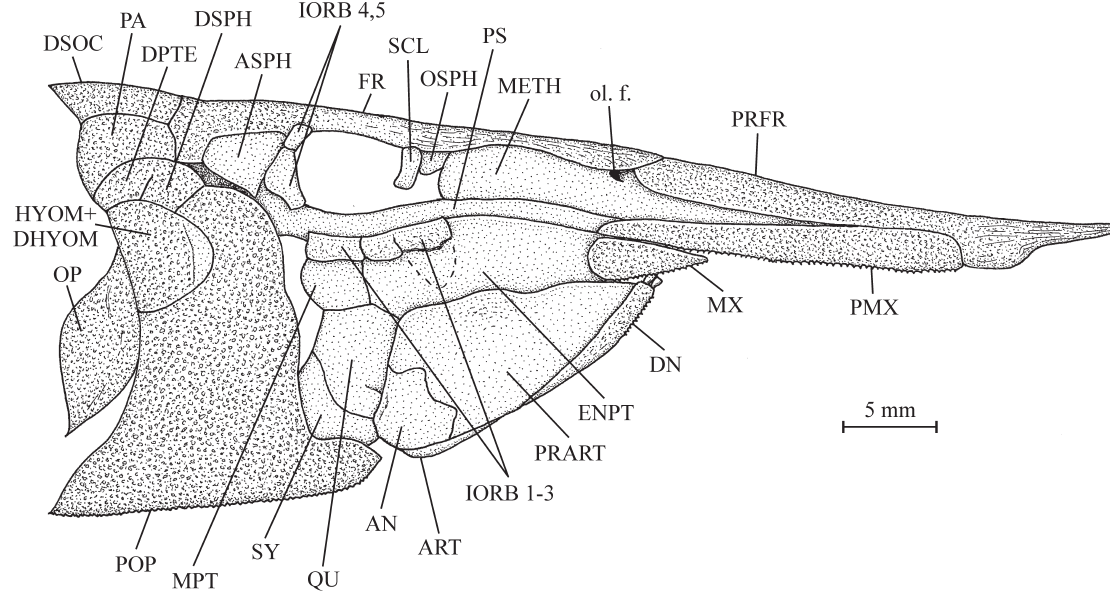
Fig. 3. Gladiopycnodus karami gen. et sp. nov. Reconstruction of the skull of holotype CLC